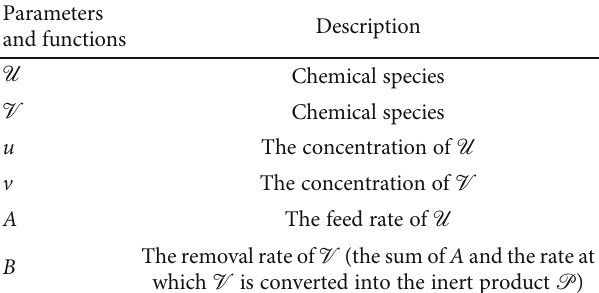
Table 1: List of parameters and